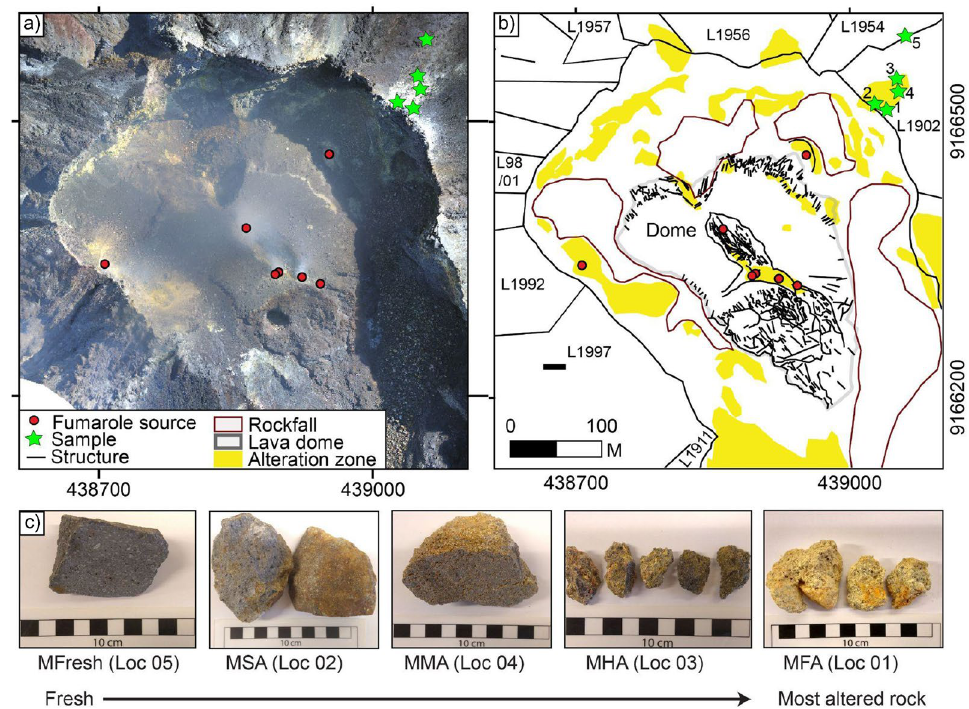
Figure 2. Hydrothermal alteration at Merapi summit in 2017. ( a ) Photomosaic of drone images acquired in 2017 used to map hydrothermal alteration at Merapi summit. No significant deformation was observed between 2015 and 2017, however, many rock falls were deposited at the western and the eastern crater floor area during this period. ( b ) Map of hydrothermal alteration, structures and active fumaroles at Merapi summit, and the sample location of the Merapi dome rocks that are used in this study (from the 1902 dome lava). ( c ) The Merapi dome rock samples show different degrees of alteration from fresh to intensely altered, as already identified by their colour changes. Mapviews were created using ArcMap (v10.5) (https:// deskt op. arcgis. com/ de/